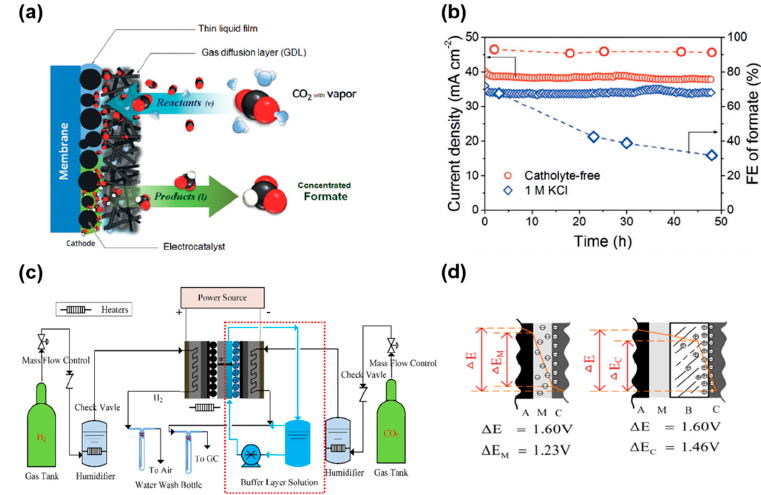
Figure 8. MEA reactor configuration and effects on a gas diffusion electrodes (GDE) incorporating Sn catalysts. ( a ) GDE system operated in the condition of catholyte-free CO 2 reduction, and ( b ) comparison of the catalytic performance under catholyte-free and 1.0 M KCl catholyte conditions. ( c ) Schematic of the MEA setup with buffer layer, and ( d ) a diagram of the potential distribution with